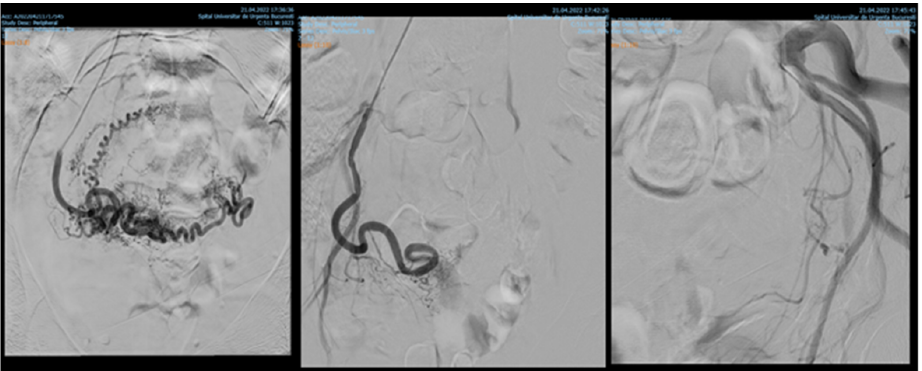
Figure 5. Pelvic artery embolization for C-scar ectopic pregnancy.